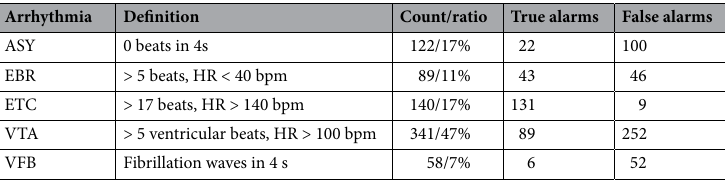
Table 1. Statistics of the PhysioNet Challenge 2015 training